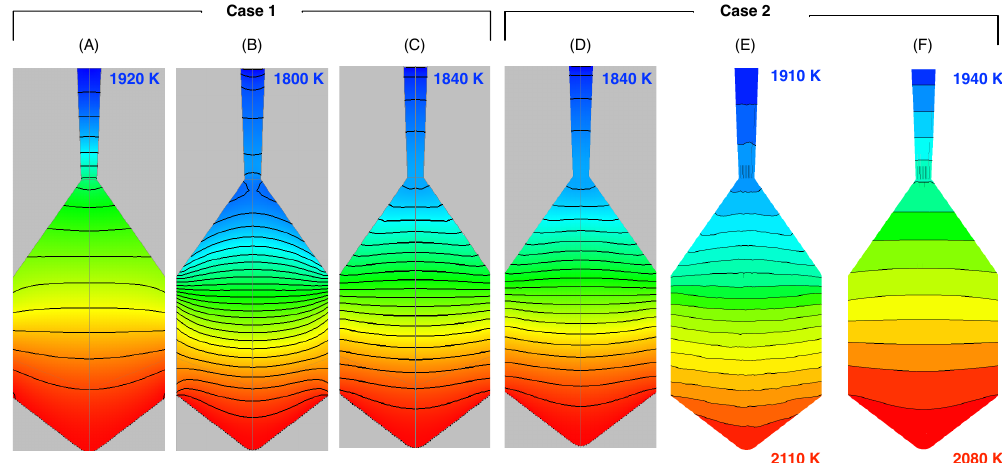
Figure 6. Temperature profiles in the crystal for different runs (isolines every 10 K): ( A ) CGsim computation with α = 1 × 10 − 5 m − 1 for Case 1; ( B ) CGsim computation with opaque crystal for Case 1; ( C ) CGsim computation with α = 400 m − 1 for Case 1; ( D ) CGsim computation with α = 400 m − 1 for Case 2; ( E ) CFX computation with α = 400 m − 1 for Case 2; and ( F ) CFX computation with transparent